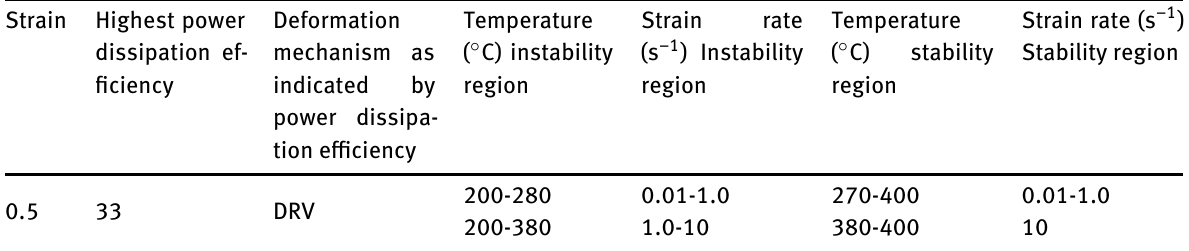
Table 1: Instability and stability regions for 6063Al/6 wt.% steel p composite.